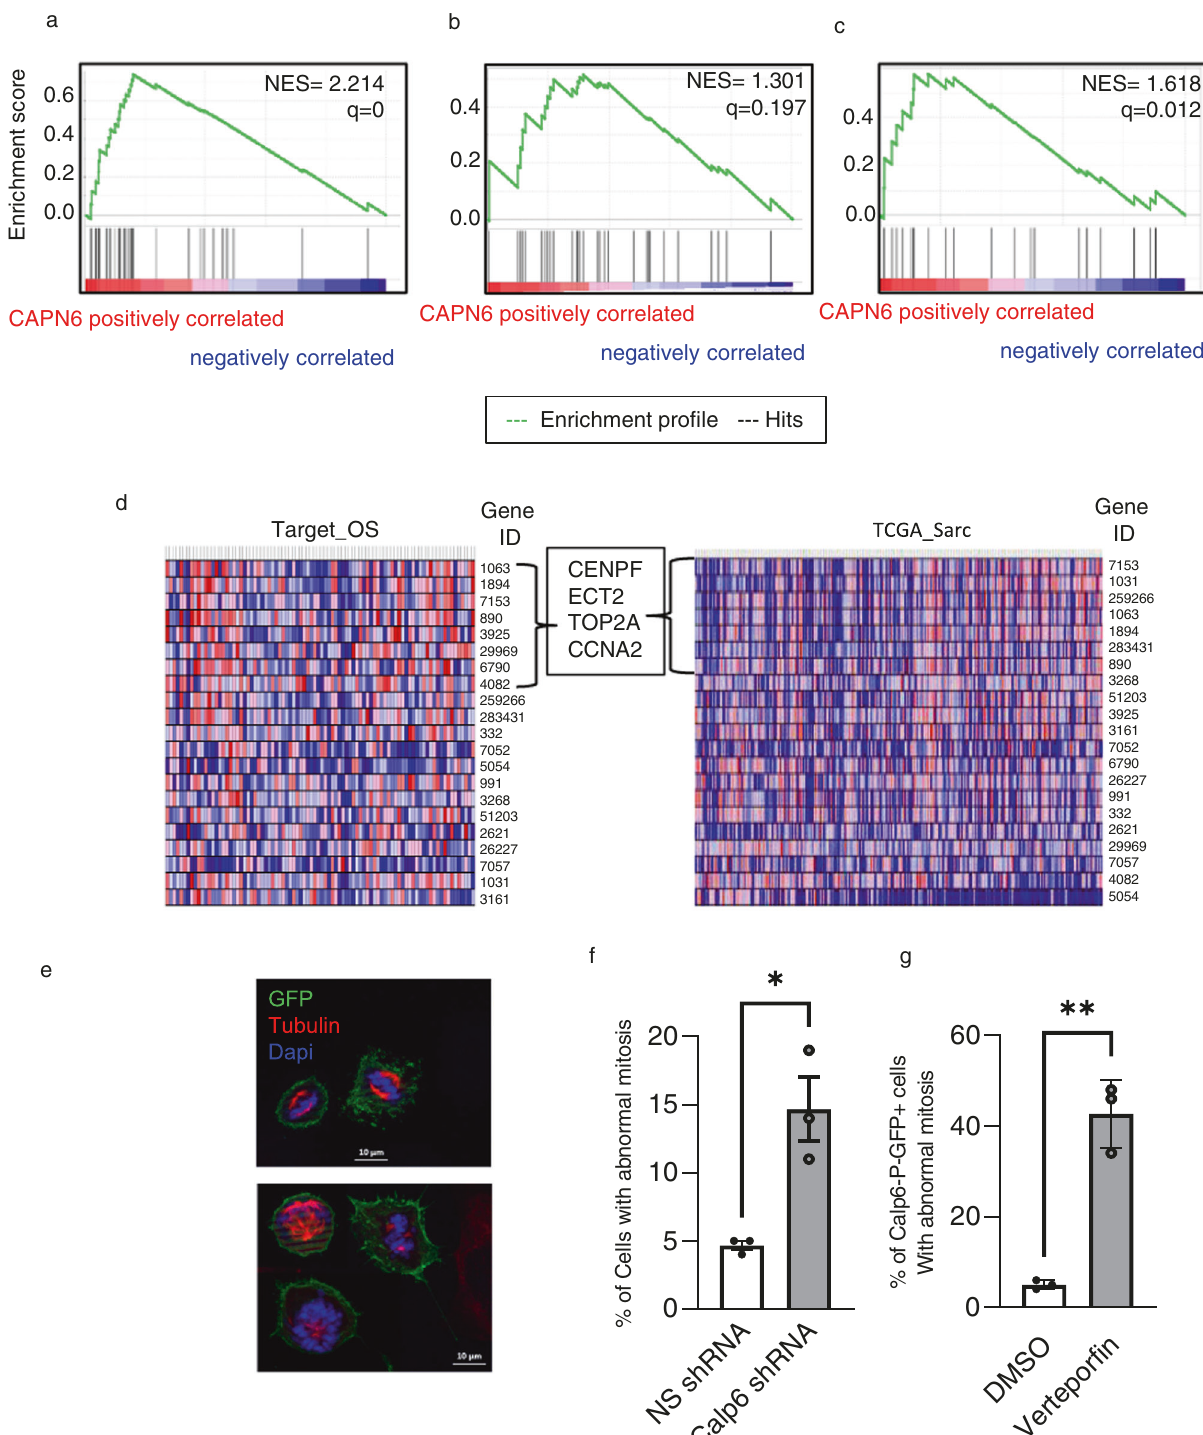
Fig. 5 Calpain-6 expression is associated with upregulation of G2M and mitotic genes in sarcomas. Calpain-6 – dependent gene set enrichment in sarcoma tissues. a , b Enrichment of G2M-positive genes in soft-tissue sarcoma (TCGA-SARC) ( a ) and in osteosarcomas (Target- OS) ( b ). c Mitotic gene set enrichment in soft-tissue sarcomas. d Heat map of variation in expression of mitotic genes (Entry gene ID as indicated) according to calpain-6 expression in osteosarcomas and soft-tissue sarcomas. e Mitosis was observed in Calp6-P-GFP + cells. DAPI staining (blue) shows the morphology of nuclei and immuno fl uorescence labeling of α -tubulin (red) shows mitotic spindle. Upper panel shows normal mitosis fi gures in control cells; lower panels show abnormal mitosis fi gures representative of mitotic catastrophe in vertepor fi n- treated or calpain-6 shRNA-expressing cells. f, g The cells were blocked in G2 overnight. Fresh medium was then added to induce the entry into mitosis. The percentage of cells with abnormal mitosis was counted comparing control and Calp6 shRNA-expressing ( f ) and DMSO vs vertepor fi n-treated 143B Calp6-P-GFP + cells ( g ). Results are means ± SEM of the percentage of catastrophe mitosis in 3 different cultures. * p < 0.05, ** p <